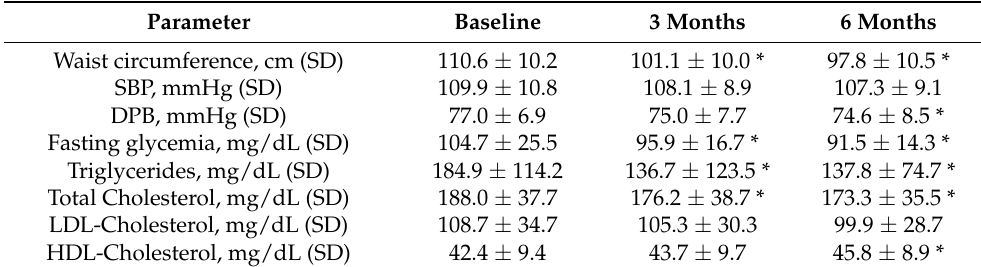
Table 2. Anthropometric and cardiometabolic changes induced by 30 mg phentermine in subjects who completed at least 3 months of treatment.